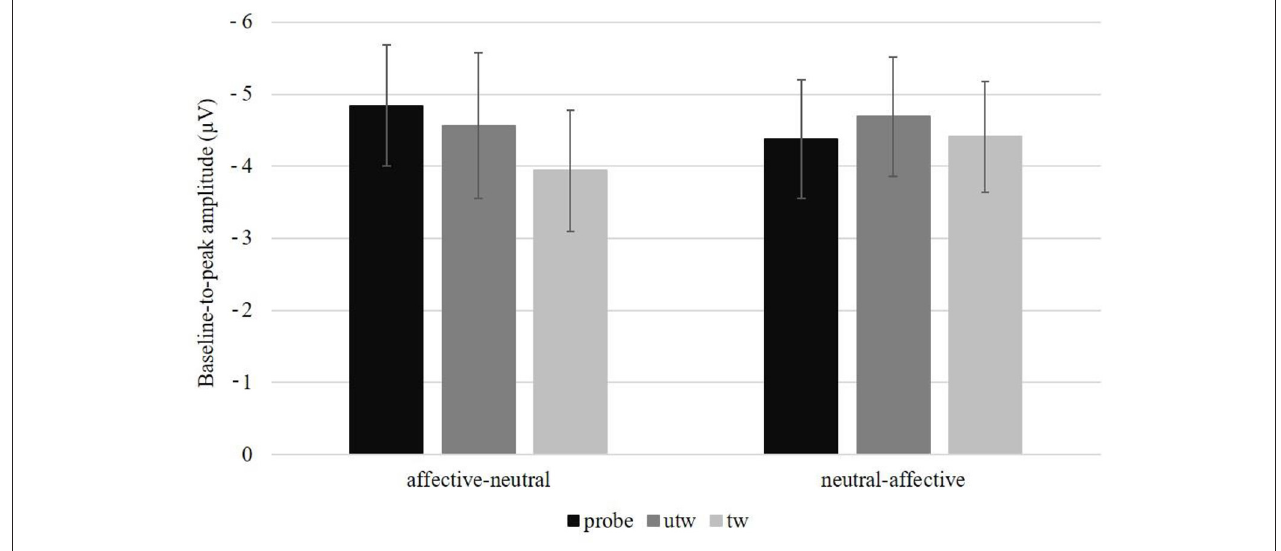
FIGURE 3 | Baseline-to-peak amplitude in microvolt ( µ V) and standard errors averaged over electrode positions (Fz, FCz, Cz, Pz) per picture type and task sequence (affective-neutral vs. neutral-affective). probe, untrustworthy-probe; utw, truthful untrustworthy; tw, truthful trustworthy.